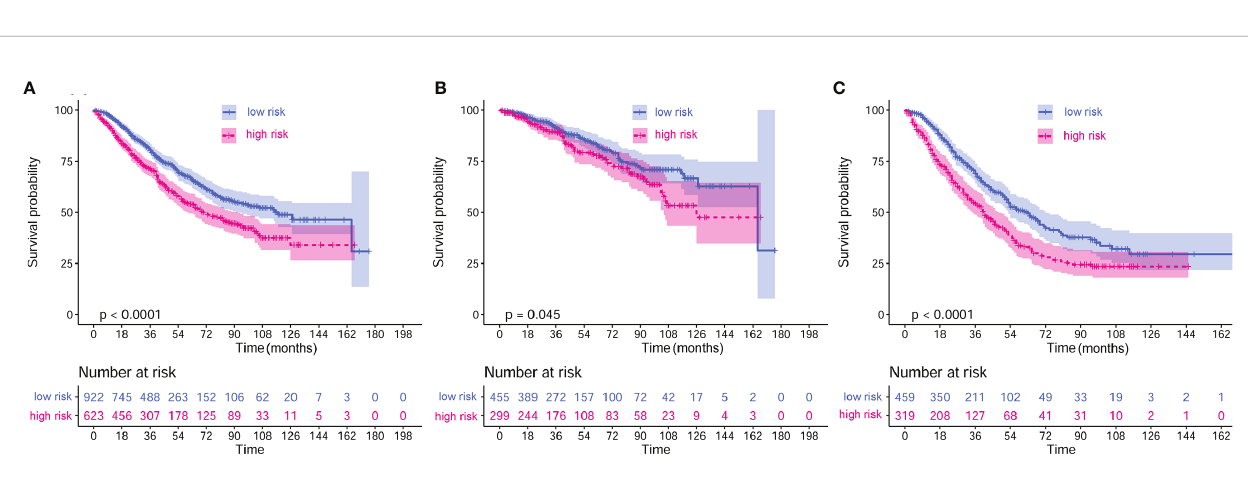
FIGURE 3 | Kaplan – Meier curves of different stages based on CRP/MCV risk strati fi cation. (A) Kaplan – Meier curves of all stages based on CRP/MCV risk strati fi cation. (B) Kaplan – Meier curves of stage I and II based on CRP/MCV risk strati fi cation. (C) Kaplan – Meier curves of stage III and IV based on CRP/MCV risk strati fi cation. A CRP/MCV value above 0.06 indicates high risk and vice versa. The abscissa represents time in months. CRC, colorectal cancer; CRP, C-reactive protein; MCV, mean corpuscular